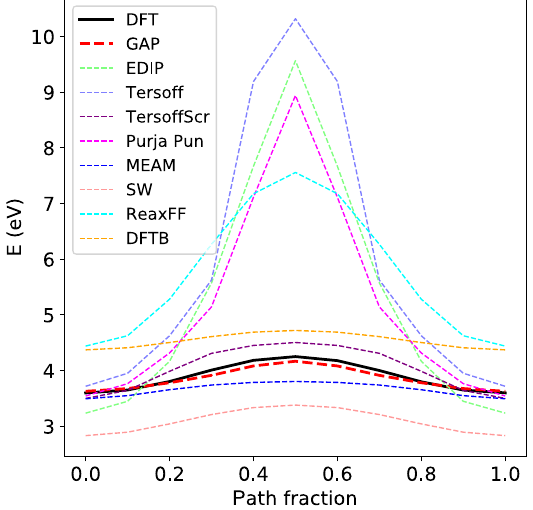
FIG. 24. Unrelaxed energy profiles for the migration of a vacancy, consisting of a series of linearly interpolated configu- rations between relaxed vacancy end points, in a 63-atom diamond cell for all models. Energies are calculated relative to a bulk crystal with the same number of atoms so that the end points indicate the relaxed vacancy formation energy.